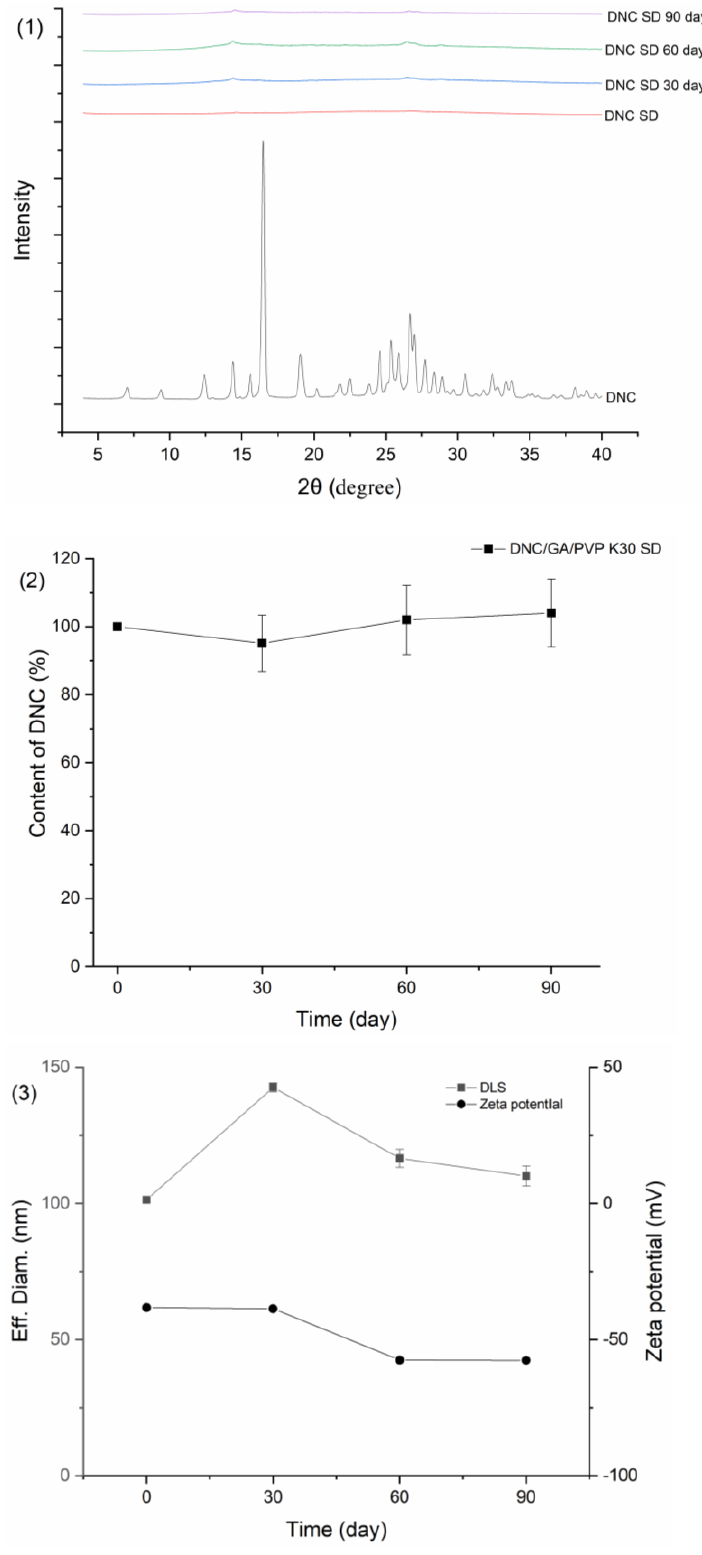
Figure 15. Stability test of ( 1 ) PXRD, ( 2 ) Drug content, ( 3 ) Particle size, and zeta potential of DNC/GA/PVP K30 SD.